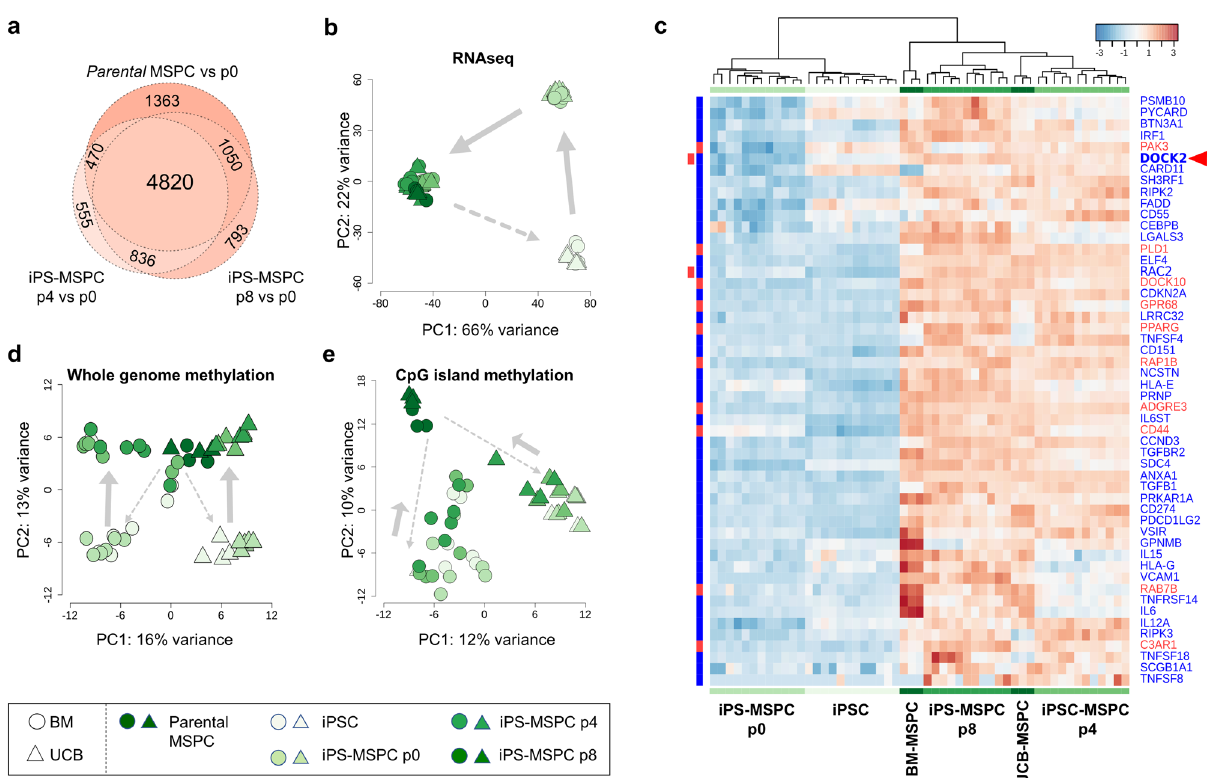
Fig. 2 Sequential methylome and gene expression analysis during MSPC-to-iPS-to-MSPC ontogeny. a Venn diagram summarizing the number of signi fi cantly >2-fold differentially regulated genes in parental MSPCs vs. iPS-MSPCs p0 and iPS-MSPCs p4 vs. p0 and p8 vs. p0, respectively (adjusted p - value < 0.05). b Principal component (PC) transcriptome analysis. c Hierarchical clustering heat map of genes linked with T-cell proliferation ( blue ) or G-protein signaling ( red ) found signi fi cantly upregulated in iPS-MSPCp8 vs. p0 and also represented in parental MSPCs. d Whole methylome levels and e CpG island methylation sub-analysis showing relationship between different samples. Gray arrows indicating differentiation trajectories. p -values were adjusted using Benjamini-Hochberg correction. (RNA-seq: iPSCs, n = 12; p0, n = 12; p4, n = 12; p8, n = 11; parental MSPCs, n = 6; MethylCap-seq: iPSCs, n = 11; p0, n = 12; p4, n = 9; p8, n = 10; parental MSPCs, n =